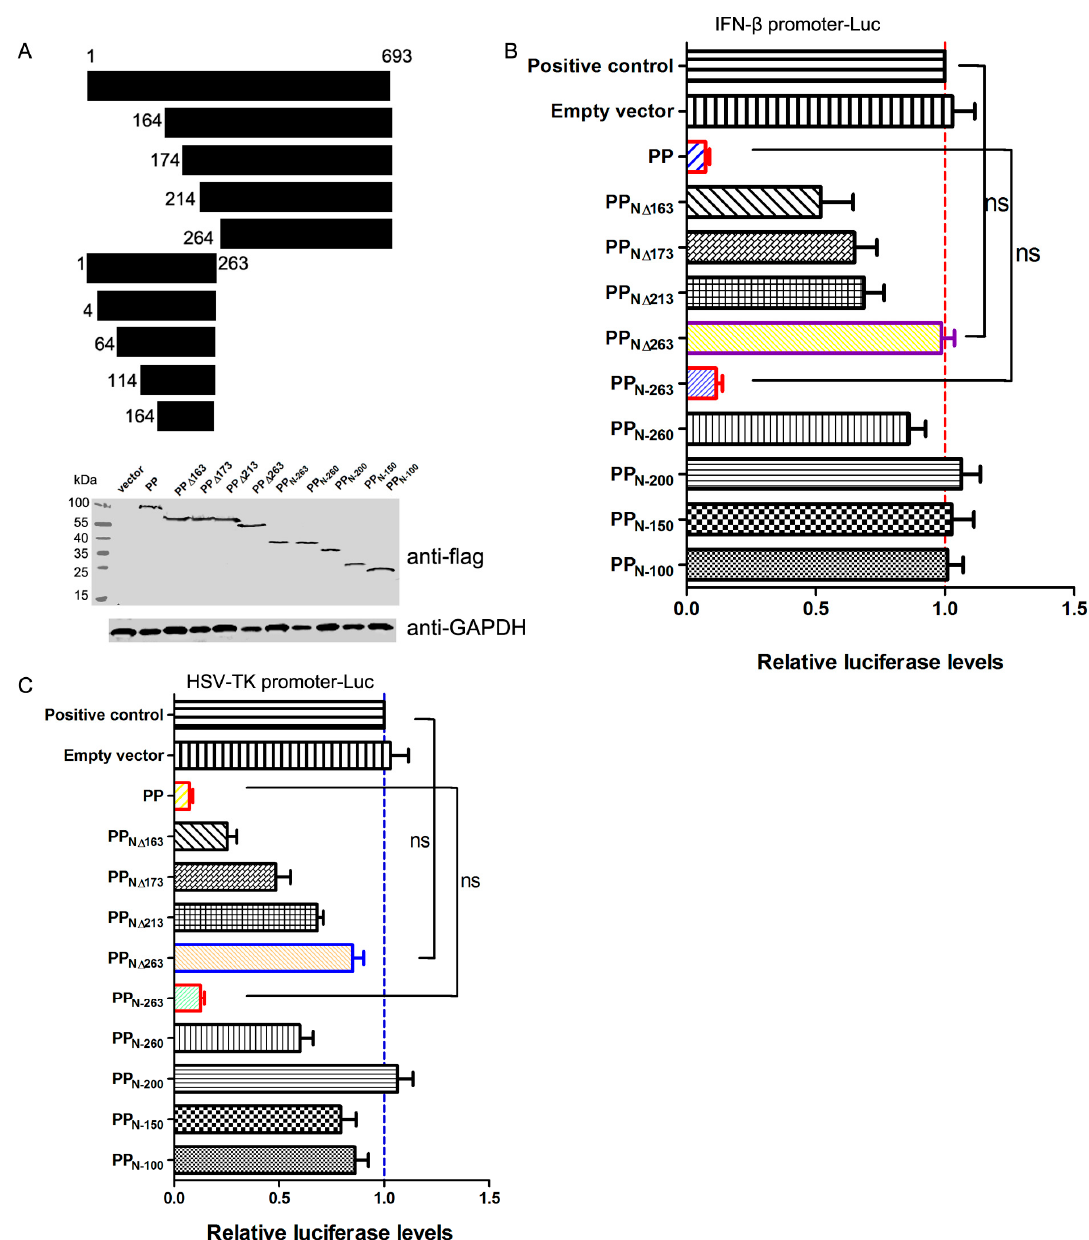
Figure 2. Screening the key domain of proteinase-polymerase (PP) required for the suppression of host gene expression. ( A ) Schematic diagram of the truncated PP constructs and the expression of each truncated mutant evaluated by Western blot using anti-Flag antibody; ( B , C ) CRFK cells were transfected with 0.25 μ g of pFlag-PP and each truncated construct or empty vector together with 0.25 μ g of the pIFN+33-Luc ( B ) or pHSV-TK-Luc ( C ) plasmids; At 24 h post-transfection, SeV (100 HA units) was inoculated into the pIFN+33-Luc transfection groups, and the luciferase assay was performed at 10 h post-inoculation. For the pHSV-TK-Luc transfection groups, the luciferase assay was performed directly at 24 h post-transfection. The positive controls were only transfected with 0.25 μ g of pIFN+33-Luc ( B ) or pHSV-TK-Luc ( C ) Three independent experiments were performed and produced consistent results. The data represented the result of one experiment and were presented as means ± SD. ns, non-significant.